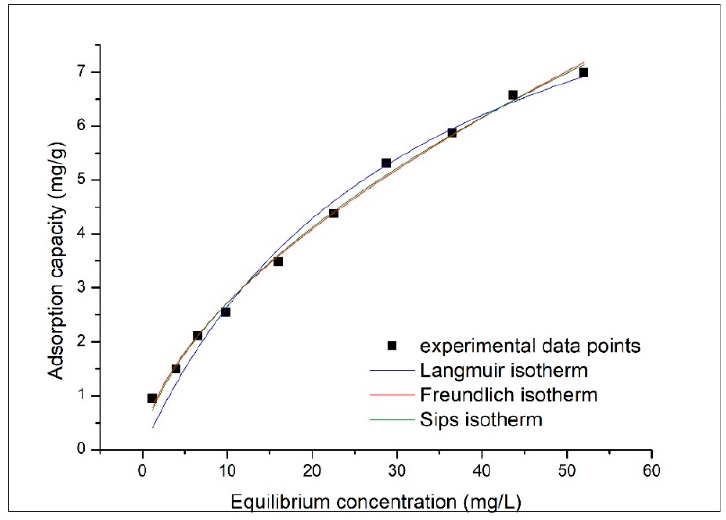
Figure 9. Adsorption isotherm model for adsorption of Pd(II) onto XAD7-DB18C6. Table 2. Parameters of isotherm model for adsorption of Pd(II) onto XAD7-DB18C6. Langmuir